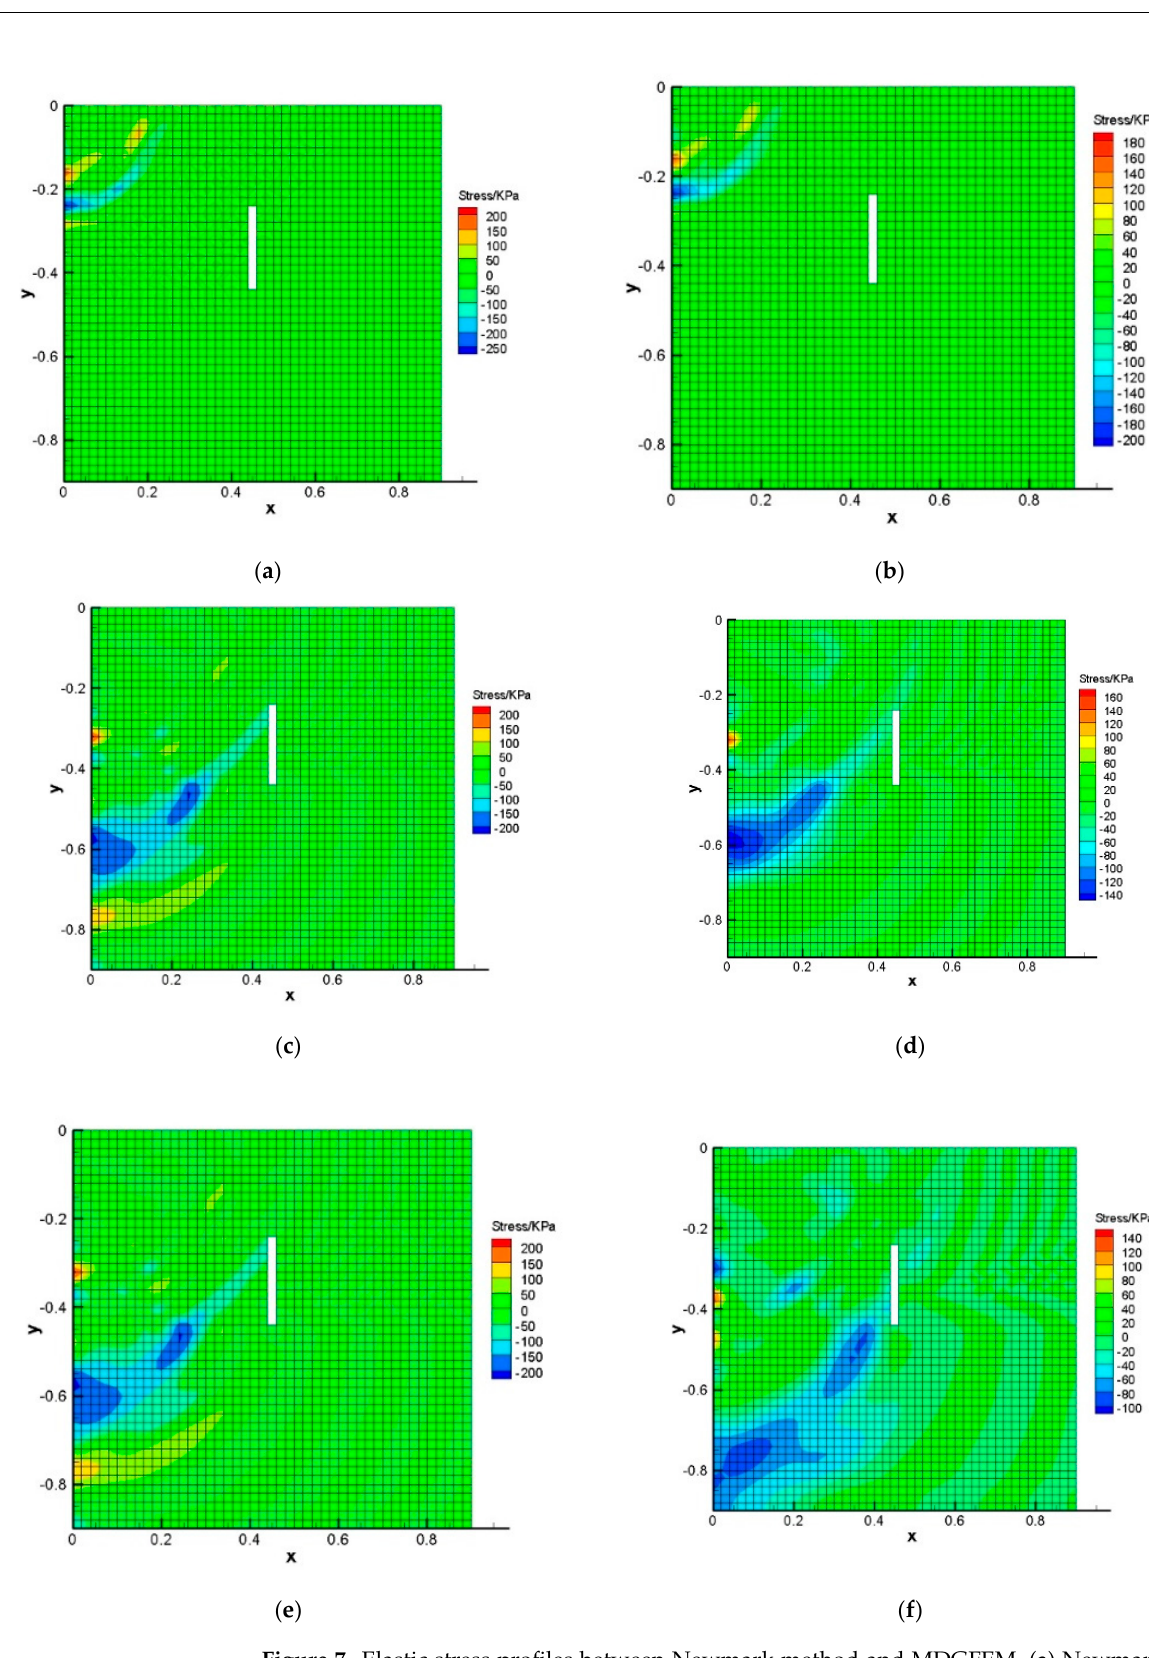
Figure 7. Elastic stress profiles between Newmark method and MDGFEM. ( a ) Newmark 0.15 μs ; ( b ) MDGFEM 0.15 μs ; ( c ) Newmark 0.3 μs ; ( d ) MDGFEM 0.3 μs ; ( e ) Newmark 0.45 μs ; and ( f ) MDGFEM 0.45 μs .